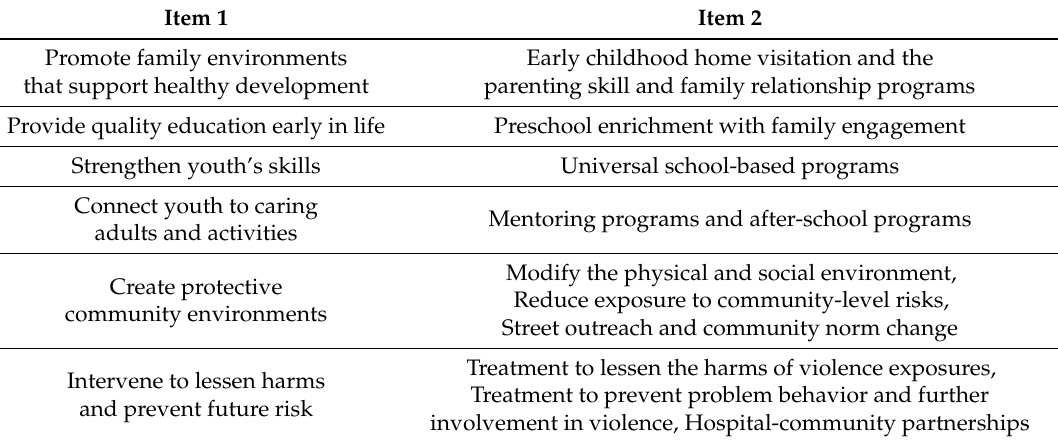
Table 6. U.S. Centers for Disease Control violence prevention